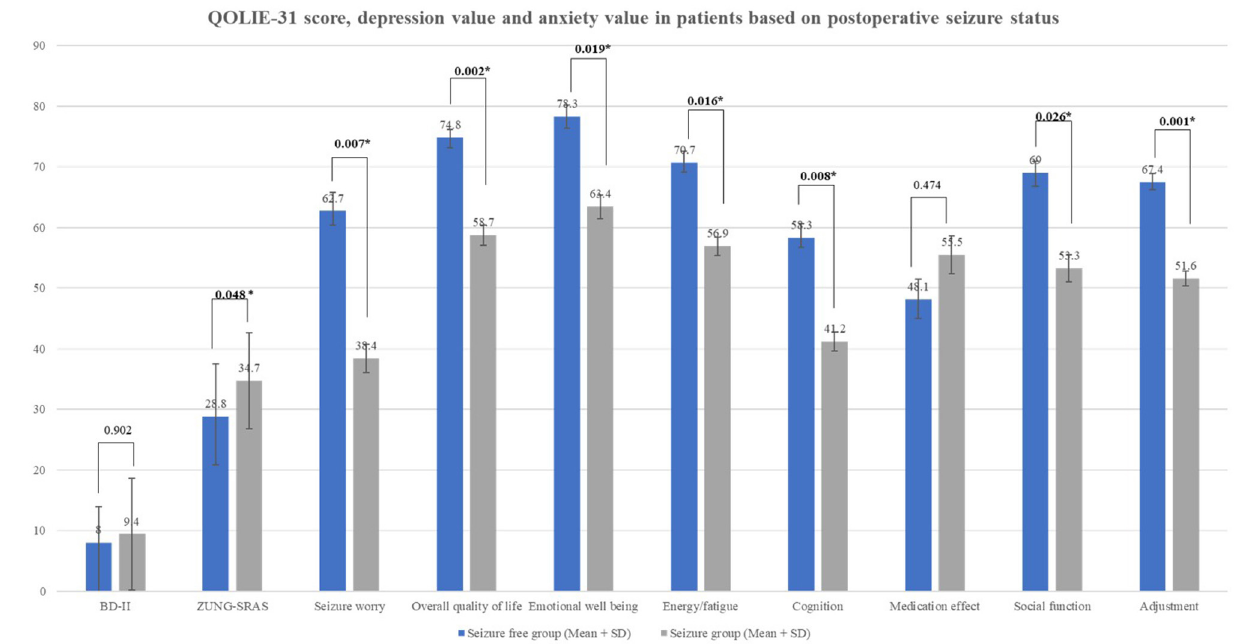
FIGURE 1 | QOLIE-31 score, depression value, and anxiety value in patients based on postoperative seizure status.